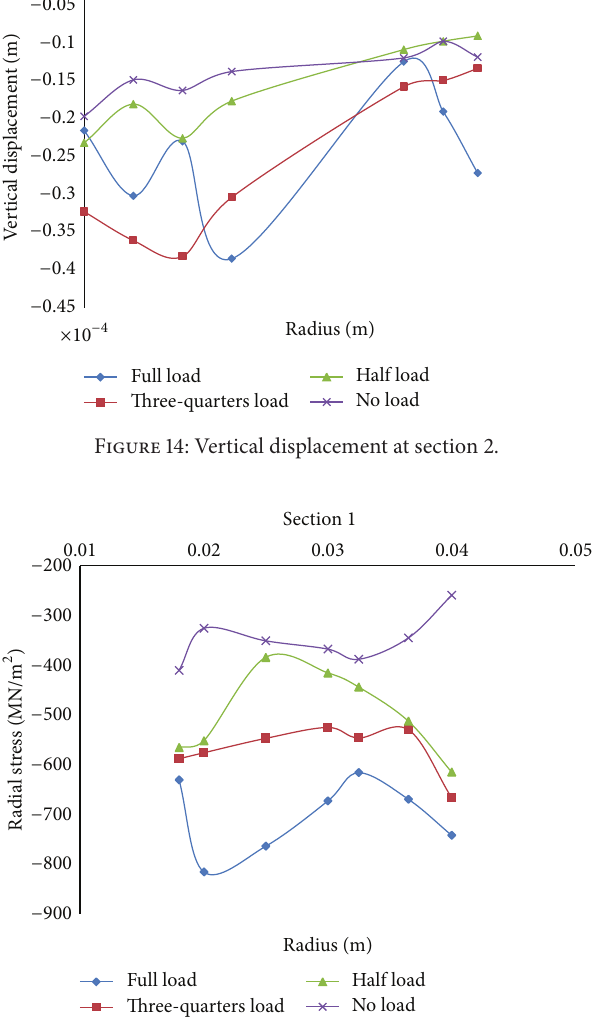
Figure 15: Variation in radial stresses at section 1.